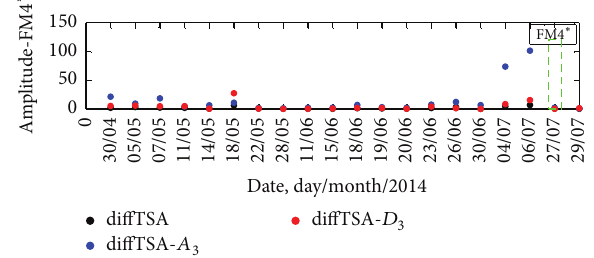
Figure 9: Sideband Index over RDLT.